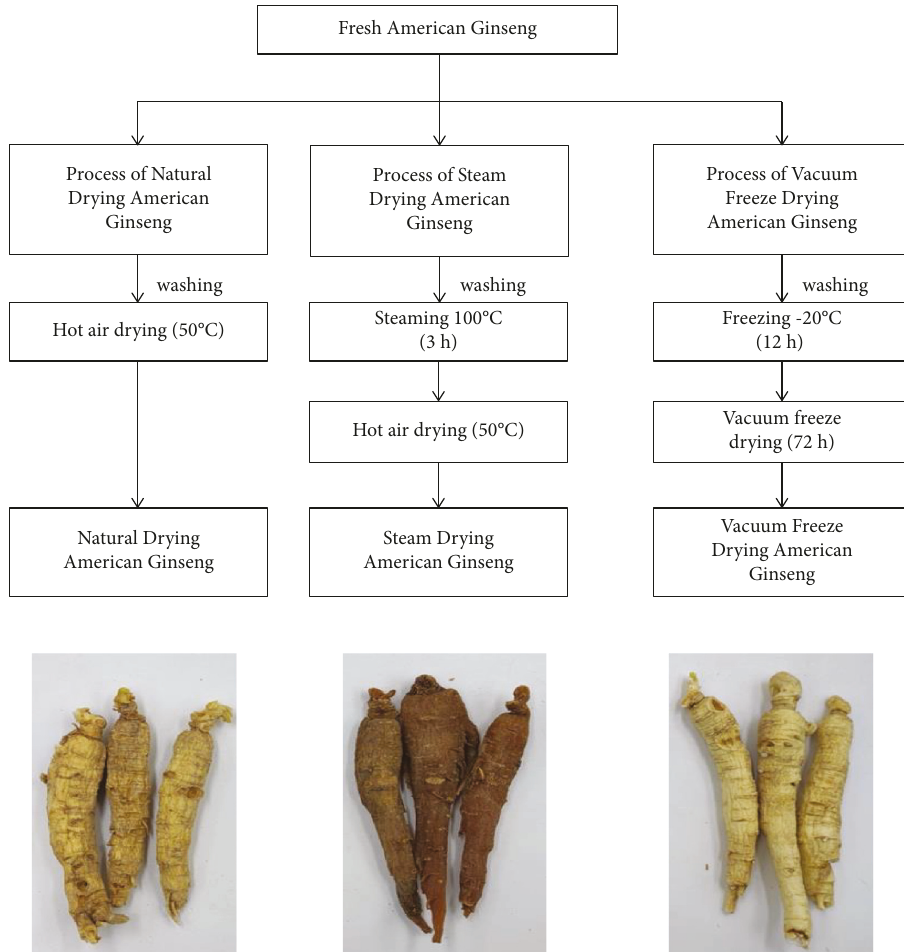
Figure 1: The scheme of American ginseng products: natural drying (ND), steam drying (SD), and vacuum freeze-drying